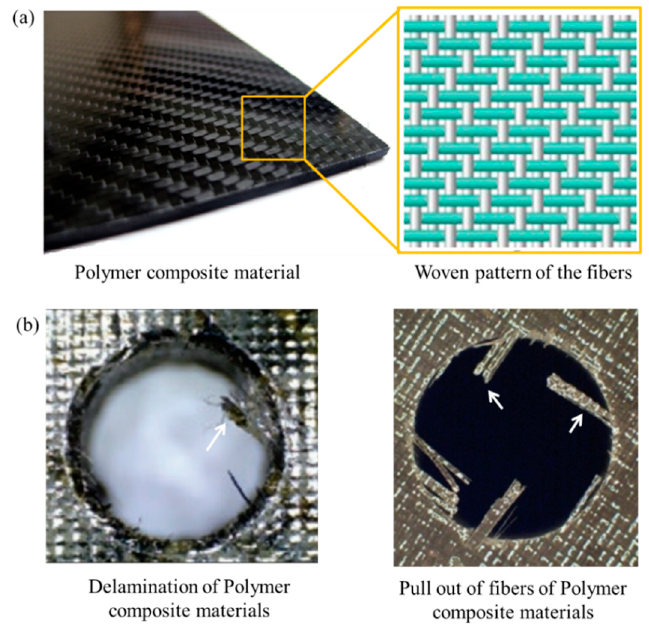
Figure 1. ( a ) Polymer composite materials and woven patterns of fibers of the reinforcement phase; and ( b ) delamination and pull out of fibers during the drilling of polymer composite materials.